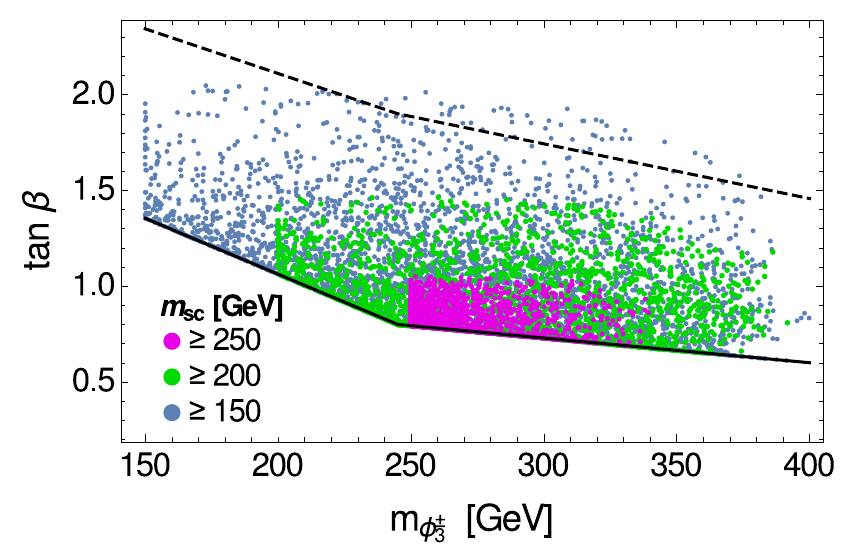
Figure 5 . Scatter plot of tan β versus the mass of the physical charged scalars ϕ ± for the colours is the same as in figure 4. The solid line and the dashed line are phenomenological bounds extracted from figure 18 of ref.